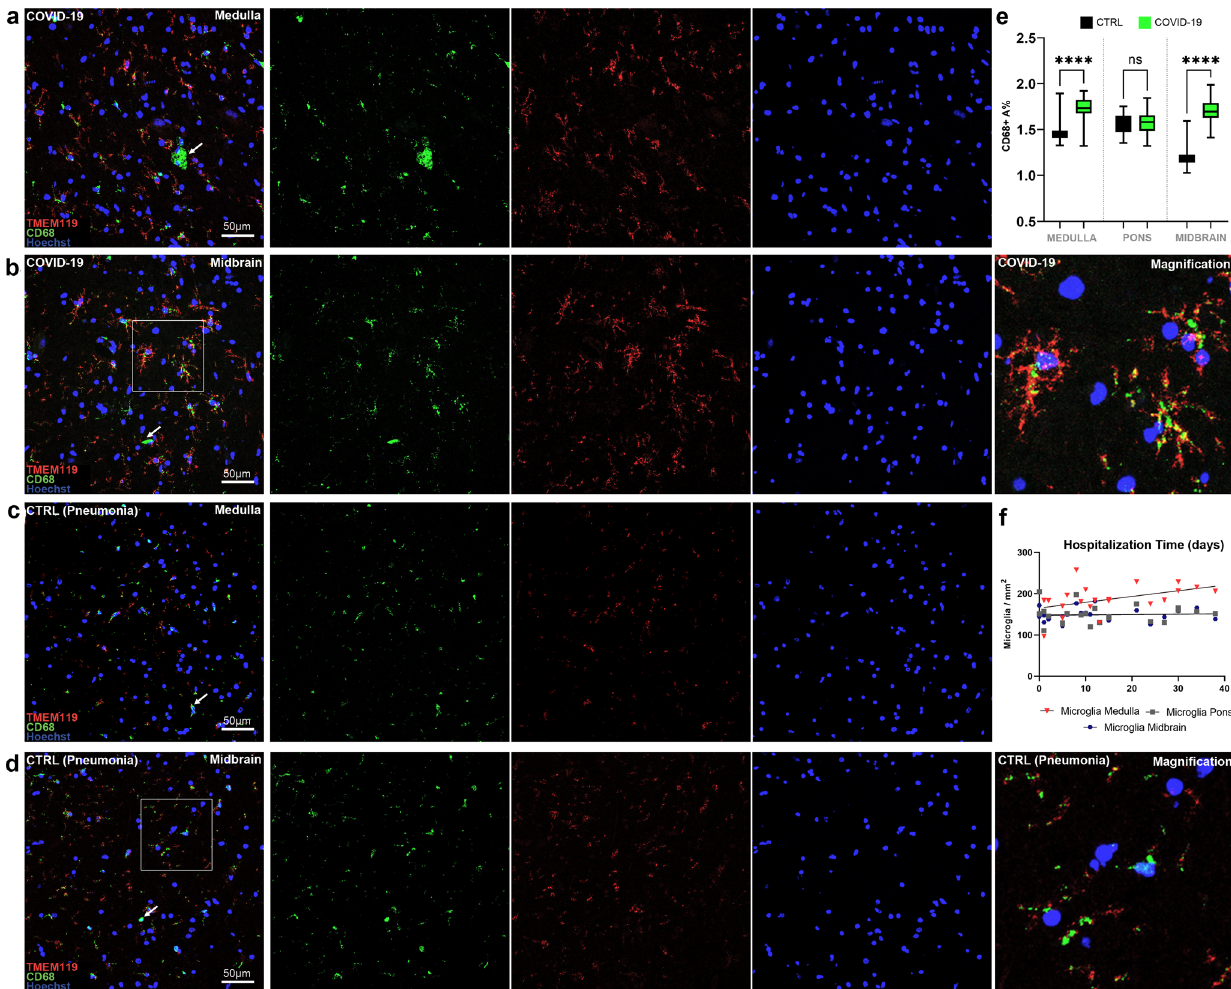
Fig. 5 Double label TMEM119 (microglia marker, red)/CD68 (lysosomal activity marker, green) fl uorescent immunohistochemistry in COVID-19 and control subjects. a , b In COVID-19, microglial cells present a distinctly activated phenotype whilst maintaining homeostatic microglial marker TMEM119 (red) and displaying increased lysosomal activity (CD68, green). Arrows indicate CD68 + /TMEM119 − monocyte/ macrophage in the parenchyma. c , d In control subjects, TMEM119 marks both the soma and sparse rami fi cations of resident microglia, suggesting less prominent activation without signi fi cant marker downregulation. CD68 immunoreactivity (green) is also present, but not as distributed as in COVID-19. e Welch one-way ANOVA of CD68 + A% in COVID-19 and controls reveals statistically signi fi cant differences between the two groups at the level of the medulla ( p < 0.0001) and midbrain ( p < 0.0001), but not the pons. The box plots boundaries represent, from the bottom to the top, the 25th percentile (lower box boundary), the median (central line) and 75th percentile (upper box boundary); whiskers represent the minimum and maximum values. f Spearman correlation between microglial densities across brainstem levels and hospitalization time reveals a statistically signi fi cant positive correlation between medullary microgliosis and hospitalization time ( r = 0.44; p =